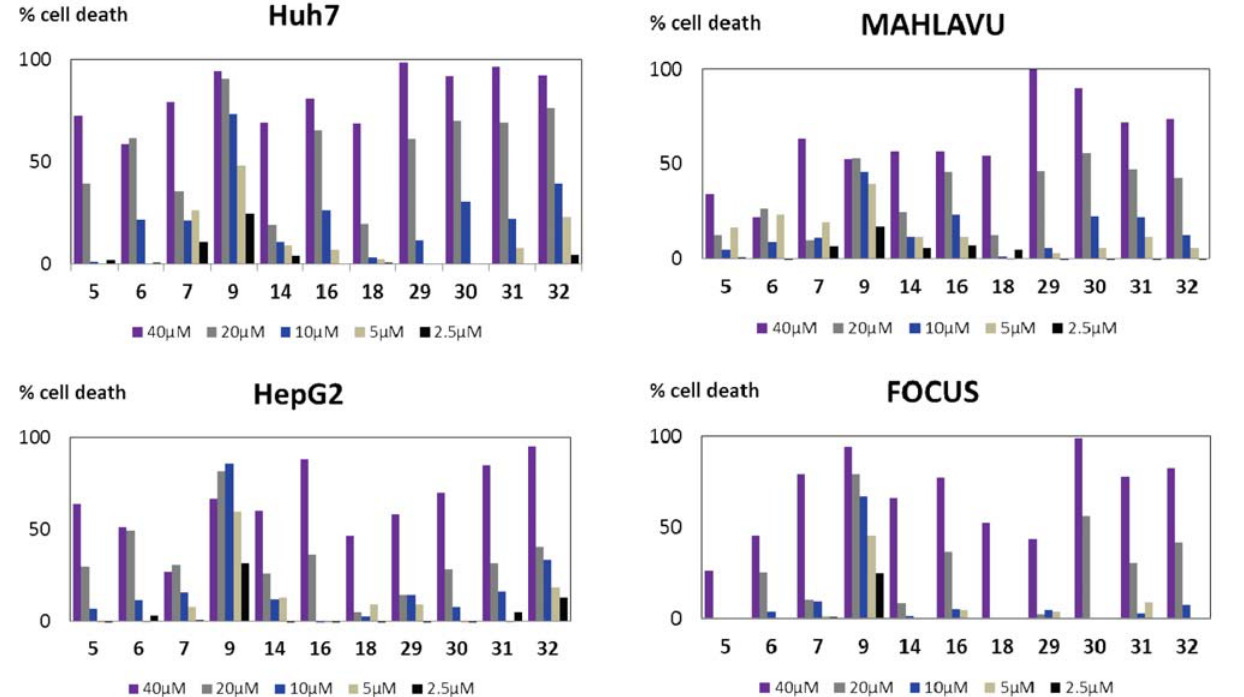
Figure 4. Percent cell death in the presence of the most active compounds. Huh7, HepG2, Mahlavu and FOCUS cells were inoculated in 96-well plates. All molecules and their DMSO controls were administered to the cells in triplicate with five different concentrations: 40, 20, 10, 5, and 2.5 μM. After 72 h of incubation, SRB assays were generated and the cell death percentages were calculated in comparison with DMSO-treated